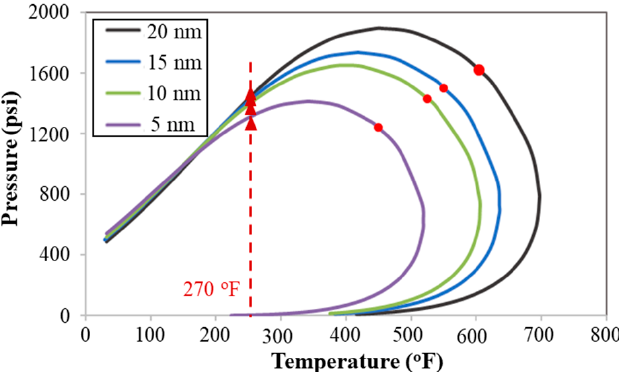
Figure 3. P ‐ T phase diagrams of different pore sizes.